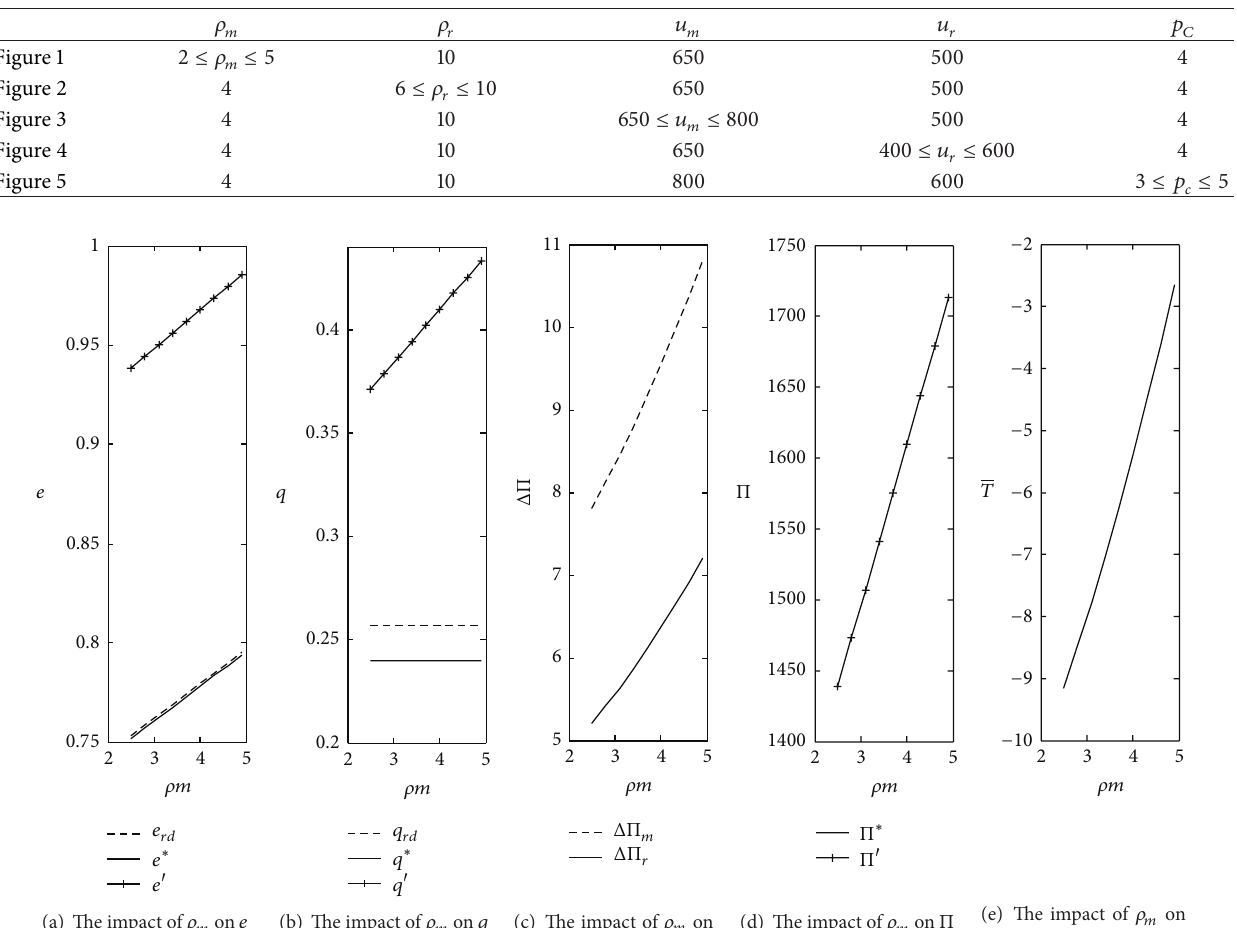
Table 1: The value of some parameters.